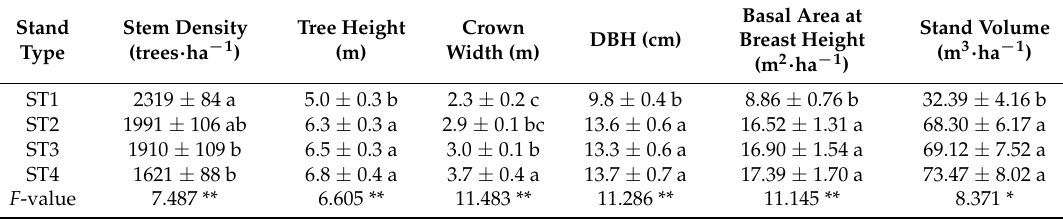
Table 3. Stand characteristics of Japanese red pine (JRP) pure forests in different stand types.